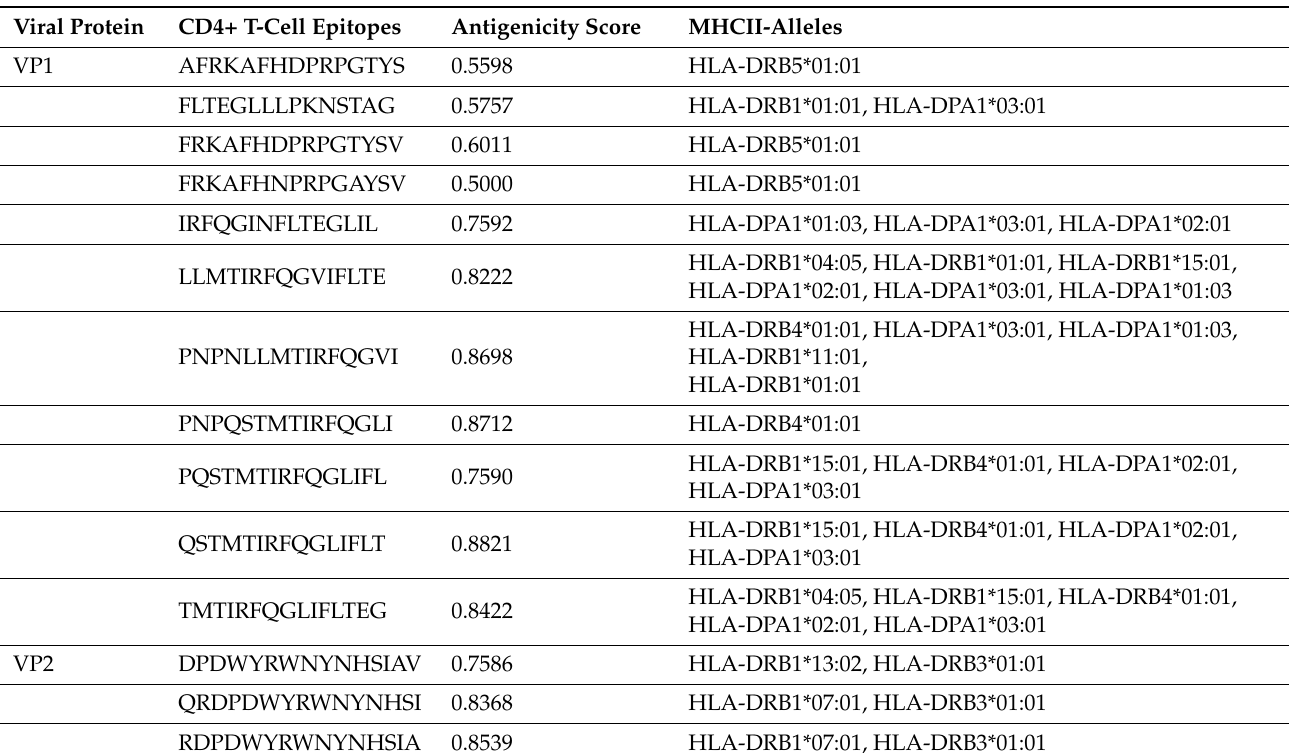
Table 2. The list of selected CD4 + T-cells epitopes of VP1 and VP2 interacting with MHC class II HLA-alleles.